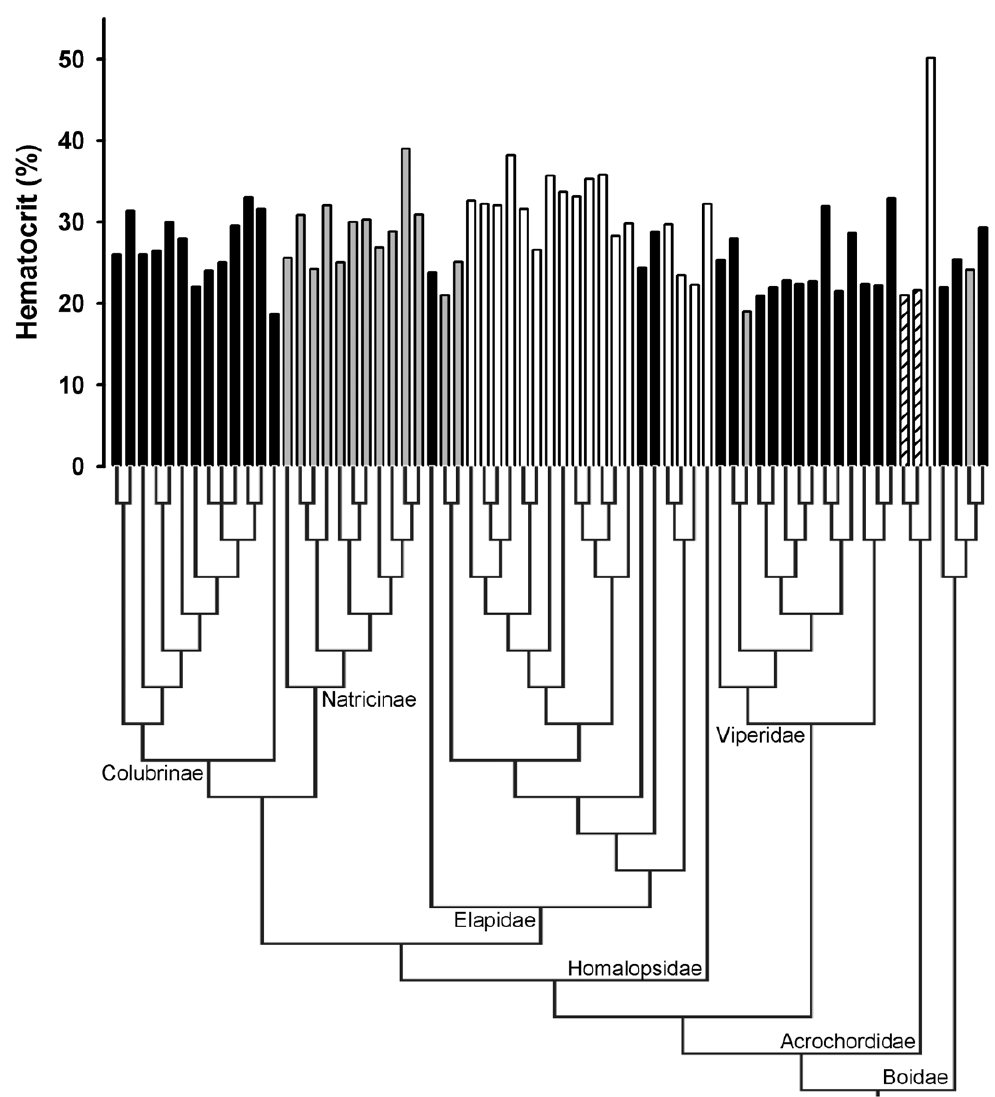
Figure 1. Phylogeny used for analyses with corresponding Hct for each species (see Online Appendix S1, S2 & S3 for details). Branch lengths represent the arbitrary method of Pagel, as used for statistical analyses. Black bars are for terrestrial species, light grey bars for semi-aquatic species, hatched bars for aquatic species, and white bars for marine species. Left-to-right order matches order of species in Online Appendix S1.